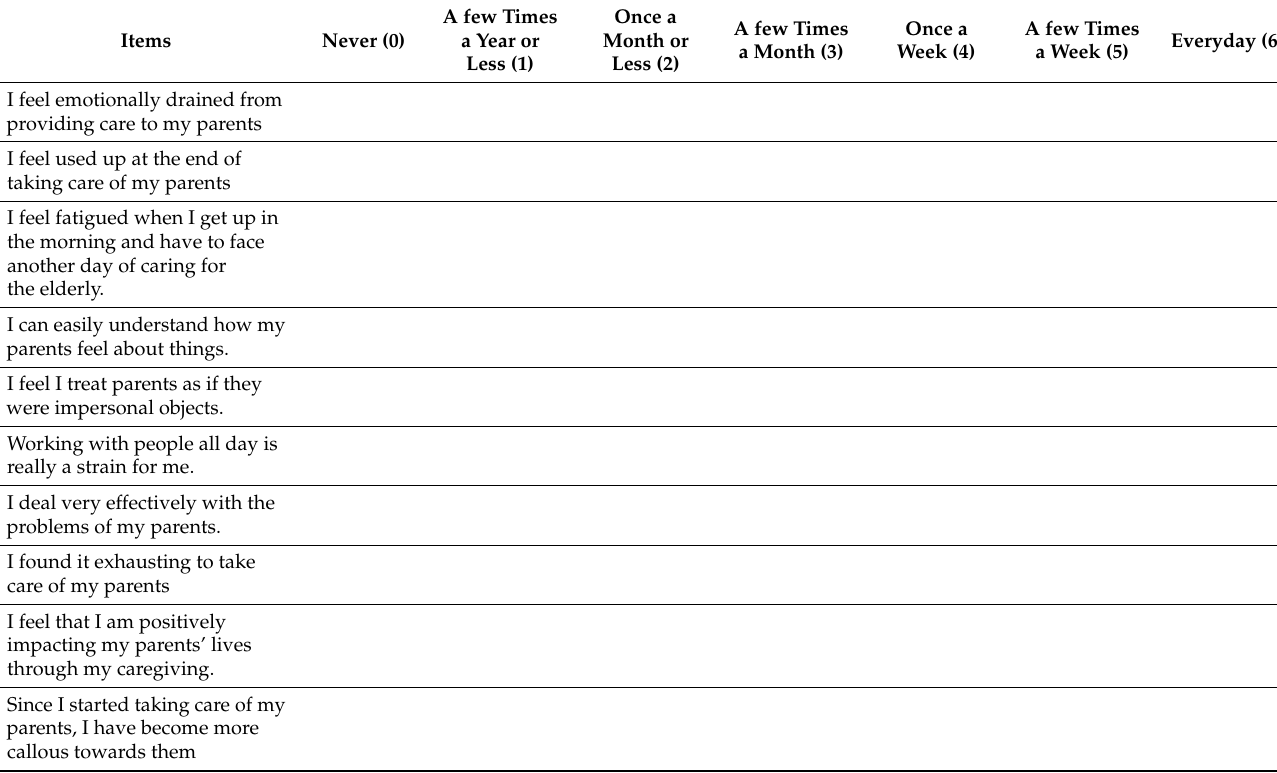
Table A3. Burnout in Caring for Grandparents